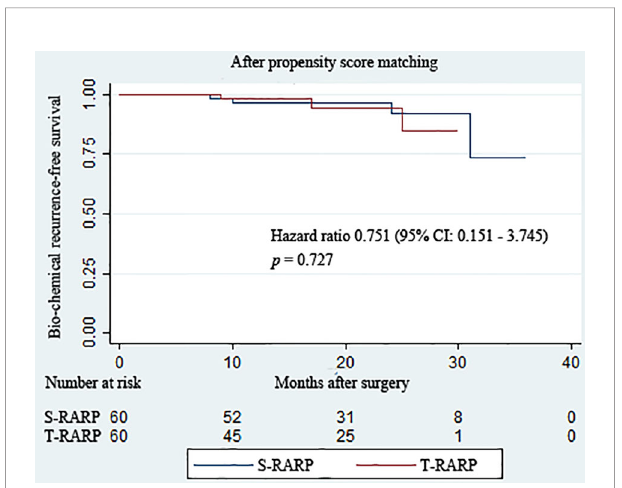
FIGURE 1 | Kaplan – Meier curves showing biochemical recurrence − free survival for patients undergoing the transvesical and standard approaches to robot-assisted radical prostatectomy during the follow-up intervals.